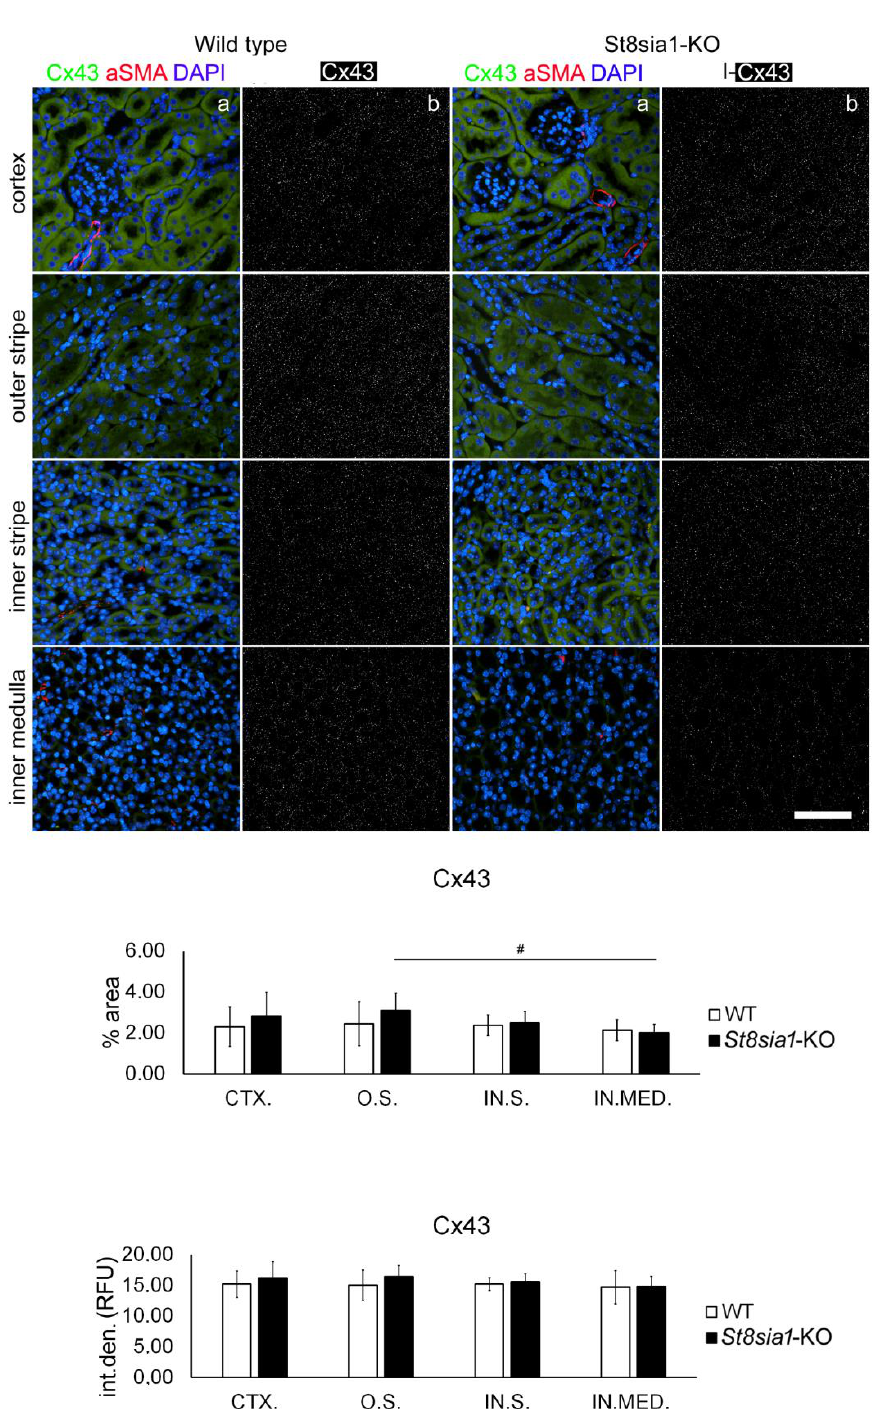
Figure 5. Expression of connexin 43 in different renal parts of the wild type and St8sia1 -KO mice. WT—wild-type mice; St8sia1 -KO— St8sia1 knockout mice; CTX.—Cortex; O.S.—outer stripe of outer medulla; IN.S.—inner stripe of outer medulla; IN.MED.—inner medulla; % area—percentage of sectional area occupied by Cx43 immunofluorescence; int.den. (RFU)—integrated density (relative fluorescence units). Column a—representative photomicrographs of the indicated kidney sections stained with Cx43 (green) and alpha-smooth actin (red) antibodies; nuclei are stained in blue. Column b—(same section as a) processed and thresholded photomicrographs prepared for analysis (inverted black for white on thresholded green image). There was no significant difference in Cx43 expression between WT and St8sia1 -KO. Comparison between different kidney areas in the same group